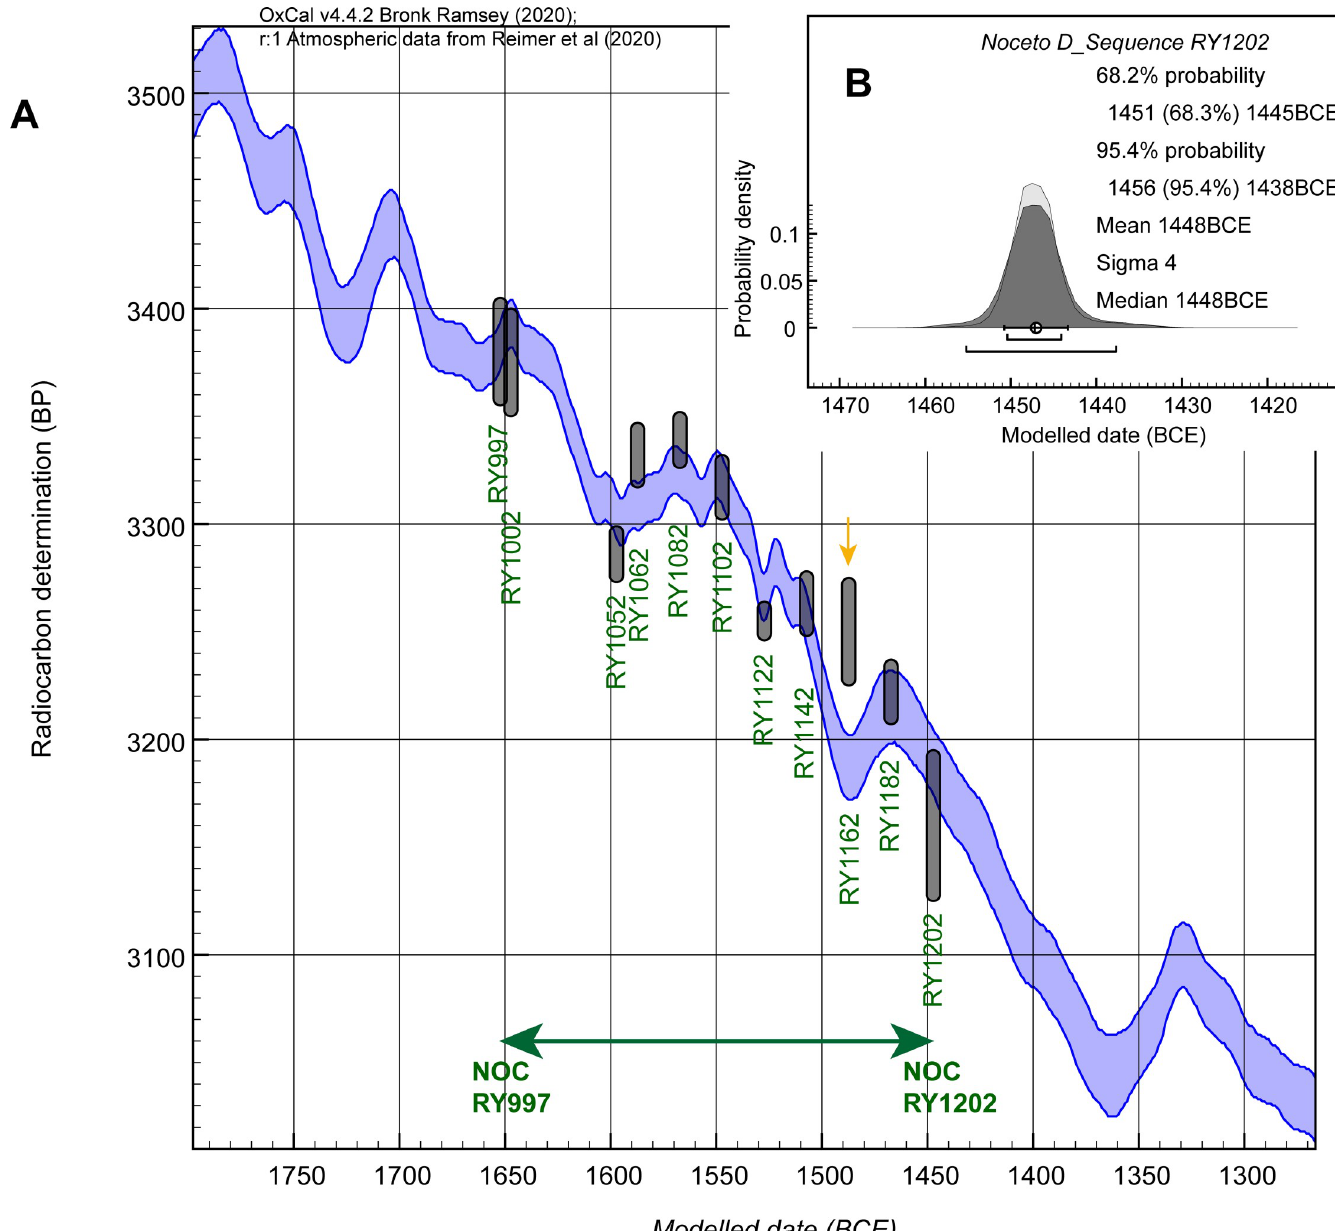
Fig 15. OxCal wiggle-match of the 11 dated NOC elements against the IntCal20 14 C calibration curve. A. 14 C dates (or weighted average 14 C values) for NOC dated elements (each 5 tree-rings/years) shown at 68.3% probability (Y axis) against the IntCal20 calibration curve (68.3% probability band) [29]. The date centered RY1162, indicated with arrow, is a minor possible outlier (outlier probability ~12%). B. The fit probabilities for the latest 14 C dated element: RY1202. Data from OxCal [26–28] version 4.4.2.